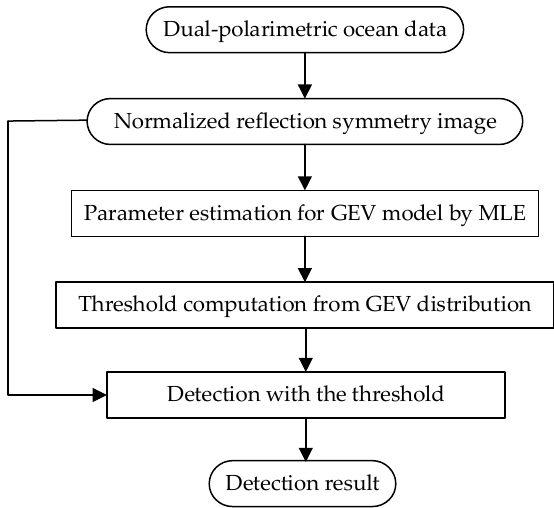
Figure 4. Generalized extreme value (GEV)-based constant false alarm rate (CFAR) detector for ocean ship using the normalized reflection symmetry image.